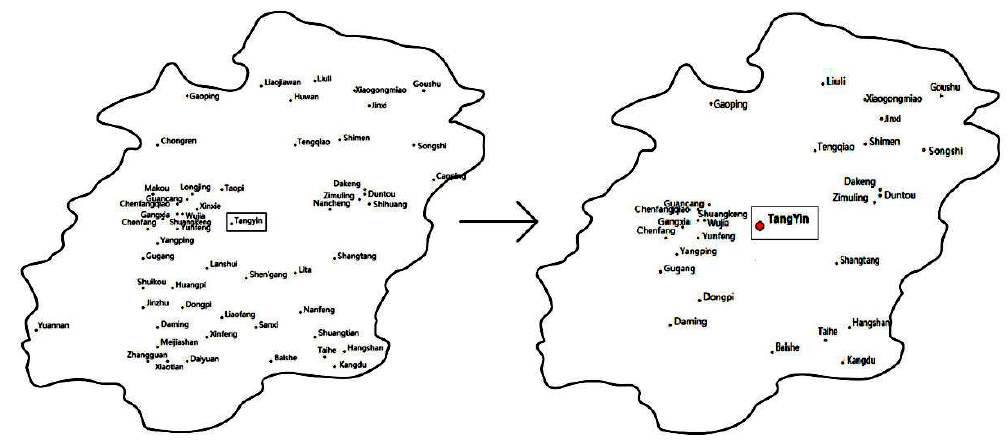
Figure 16. Schematic map of rainfall stations around the Tang Yin station.